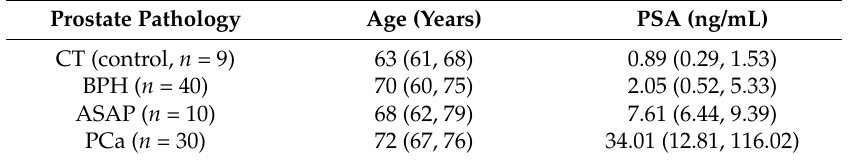
Table 1. Measured values for age and prostate-specific antigen (PSA) levels in patients with different prostate